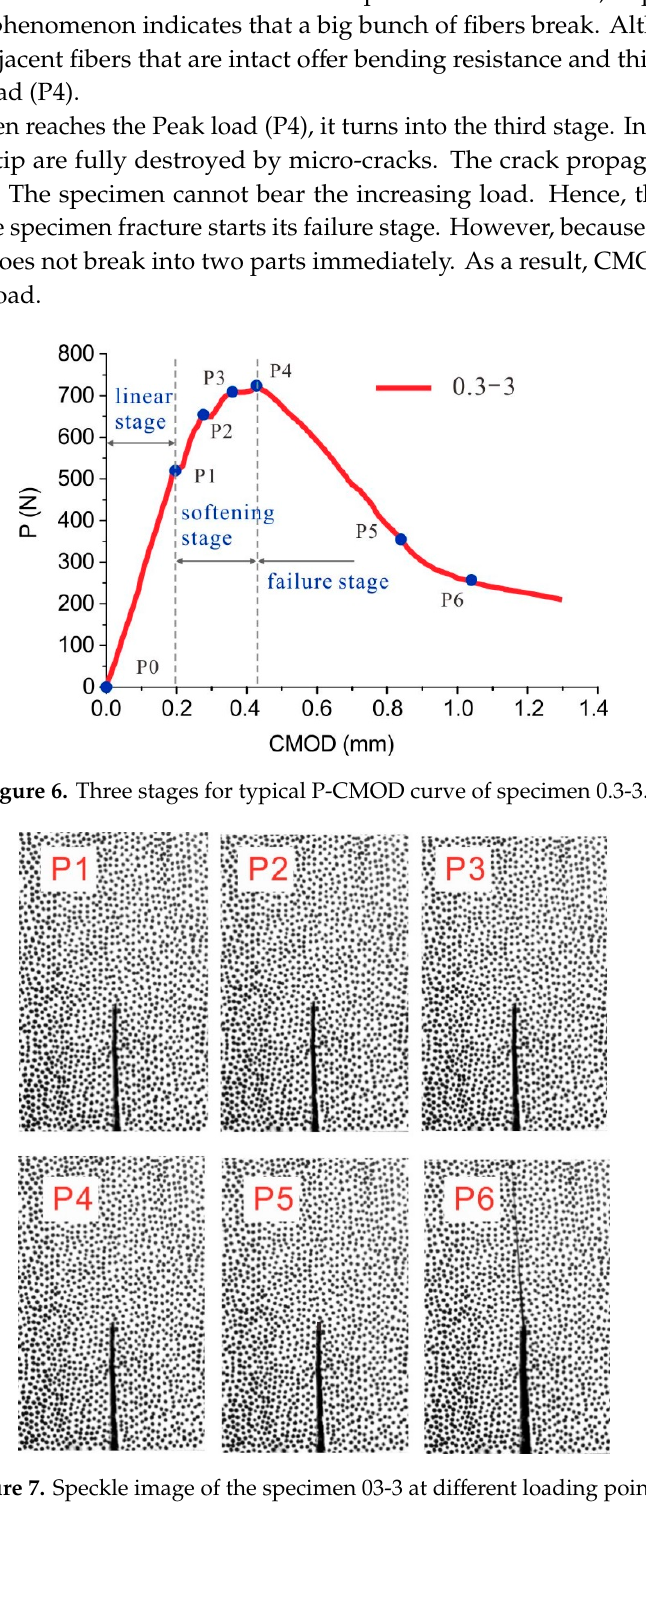
Figure 7. Speckle image of the specimen 03-3 at different loading points.